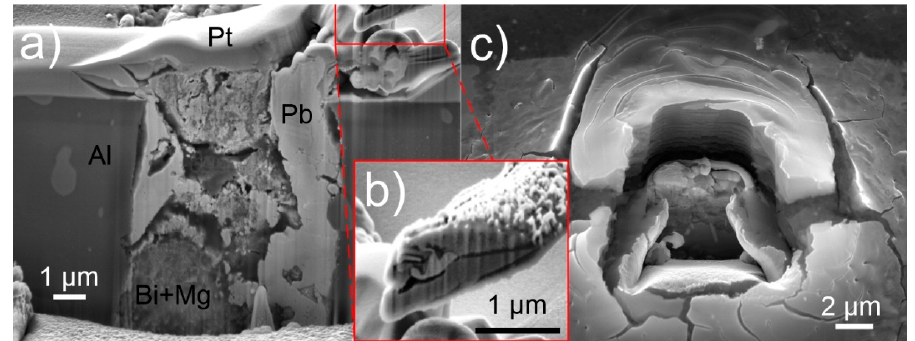
Figure 7. ( a ) Cross-sectional view of a Pb-Bi-Mg pool covered with Pt protection layer. The individual regions of the cross-section are marked with their main elemental composition. ( b ) Cross-sectional view of Pb whisker grown from pool presented in ( a ). ( c ) Image of a focused ion beam milled trench after exposure for 24 h in ambient environment showing a stress-induced fracture formation.